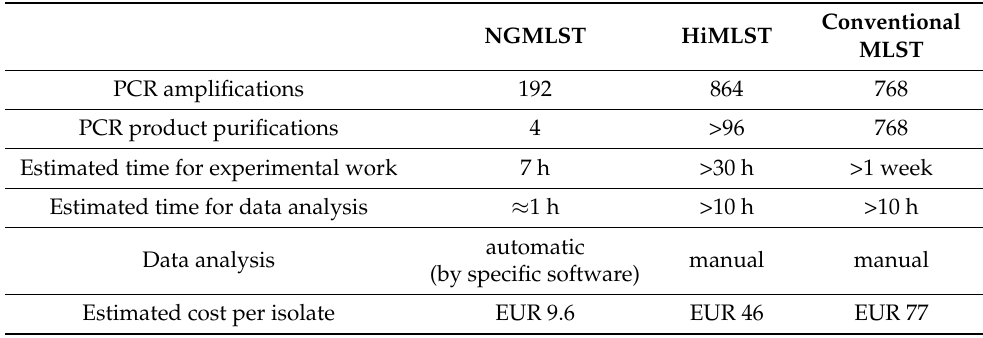
Table 2. Comparison between NGMLST, HiMLST, and conventional MLST based on 96 isolates with 8 target loci (adapted from